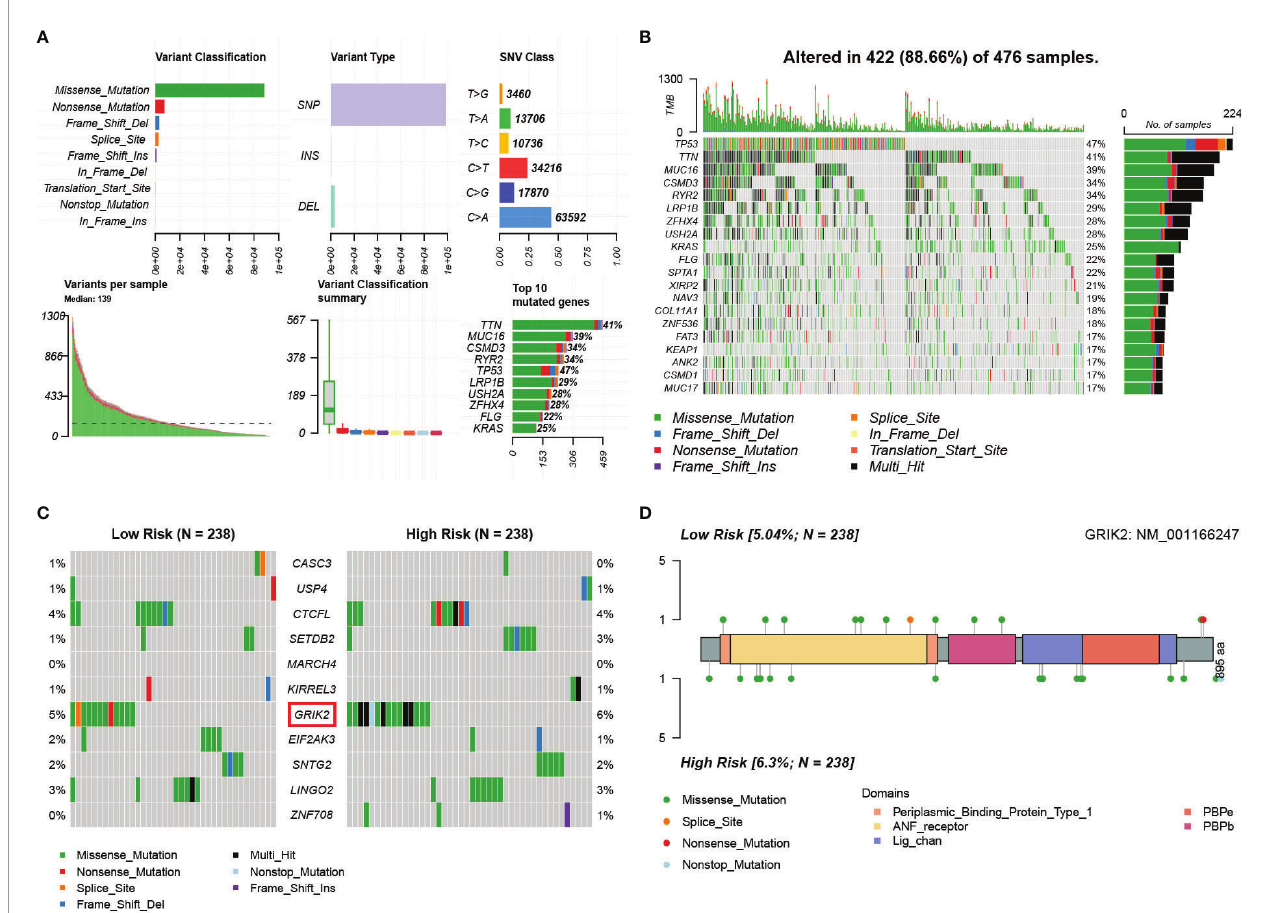
FIGURE 14 | Landscape of somatic mutations in lung adenocarcinoma patients in TCGA. (A) the summary of the mutation data. (B) The waterfall plot of the mutation distribution of the top 20 most frequently mutated genes. (C) The waterfall plot of the mutation distribution of 11 predictors between two risk groups in the mRNA model. (D) The lollipop pot of the differential distribution of variants of GRIK2 between two risk groups in mRNA